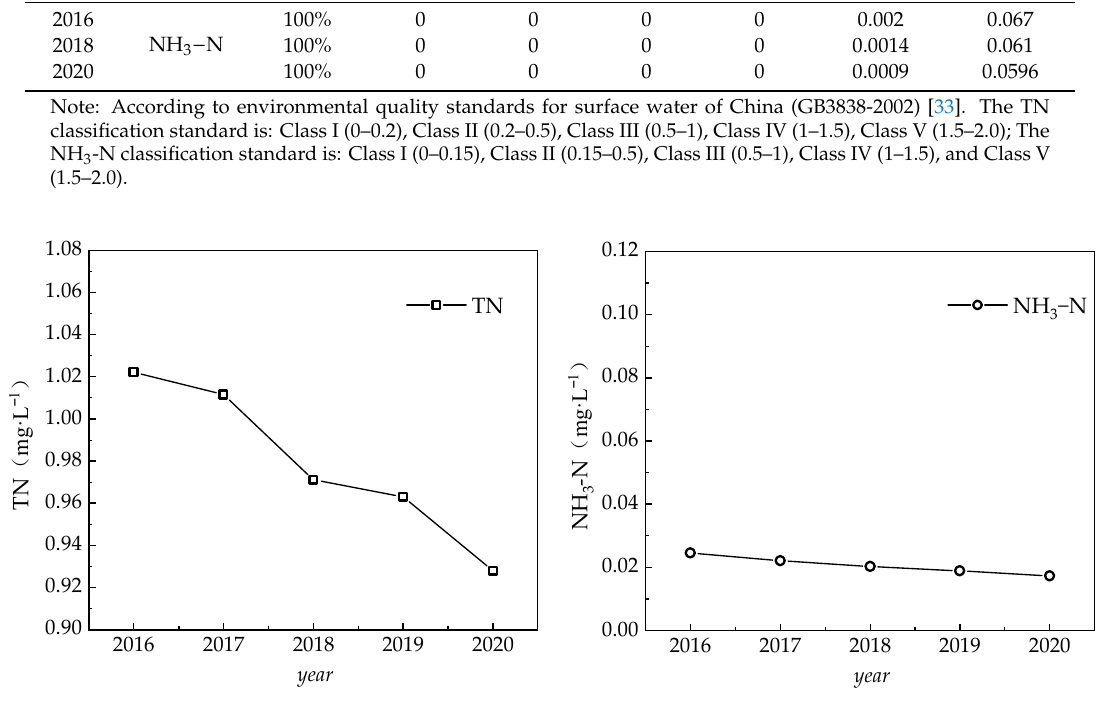
Table 3. Changes of TN and NH 3 -N concentrations during the study period.